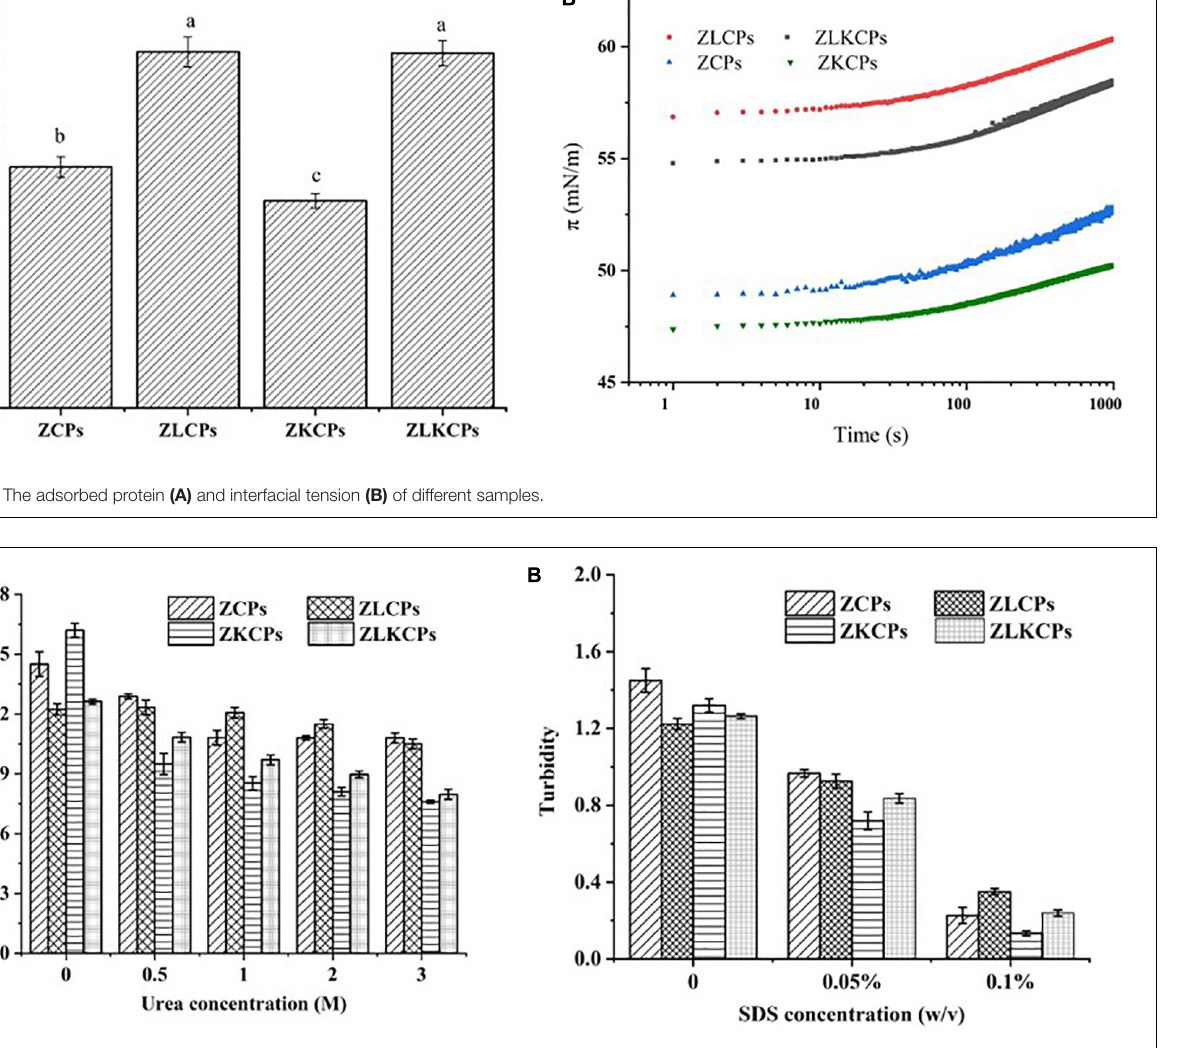
FIGURE 7 | Effects of different dispersants on colloidal particles: (A) Urea; (B)